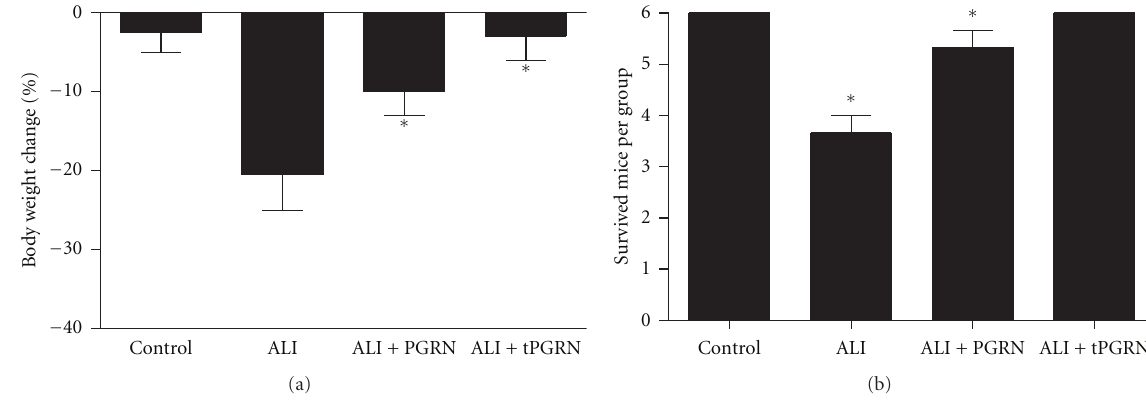
Figure 2: Administration of PGRN maintained the body weight and survival of ALI mice. Groups of mice were challenged with LPS and treated with PGRN 30min later. The tPGRN represented that PGRN was administered twice at 40h intervals. Three days after LPS challenge, the mice were assayed for their body weight relative to the baseline (a) and survival (b). Three animal experiments and each time has six animals per group were performed. ∗ P < 0 .